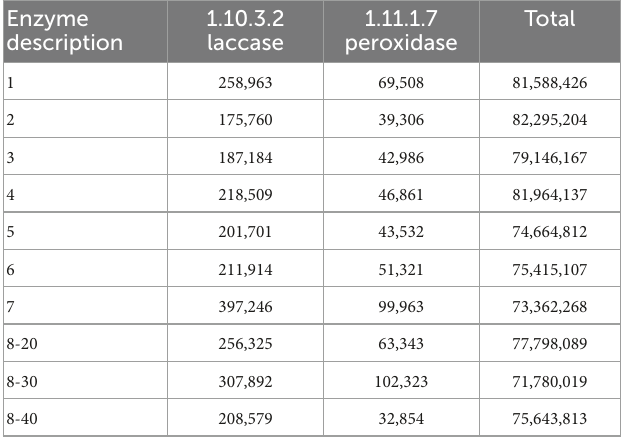
TABLE 2 Enzyme abundance of fungi by PICRUSt